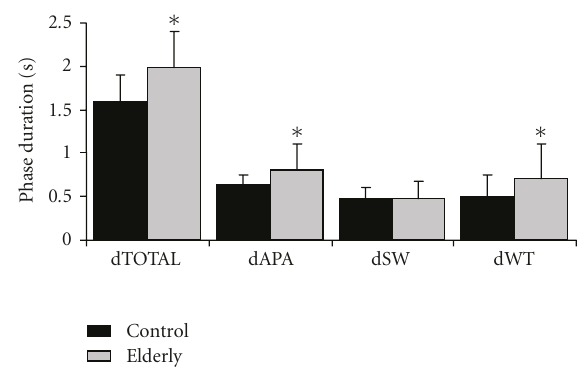
Figure 7: Temporal parameters during stepping down. dTOTAL: total movement; dAPA: anticipatory postural adjustment; dWT: weight-transfer phase duration; dSW: swing phase duration. ∗ de- notes being significantly di ff erent from control subjects ( P < .